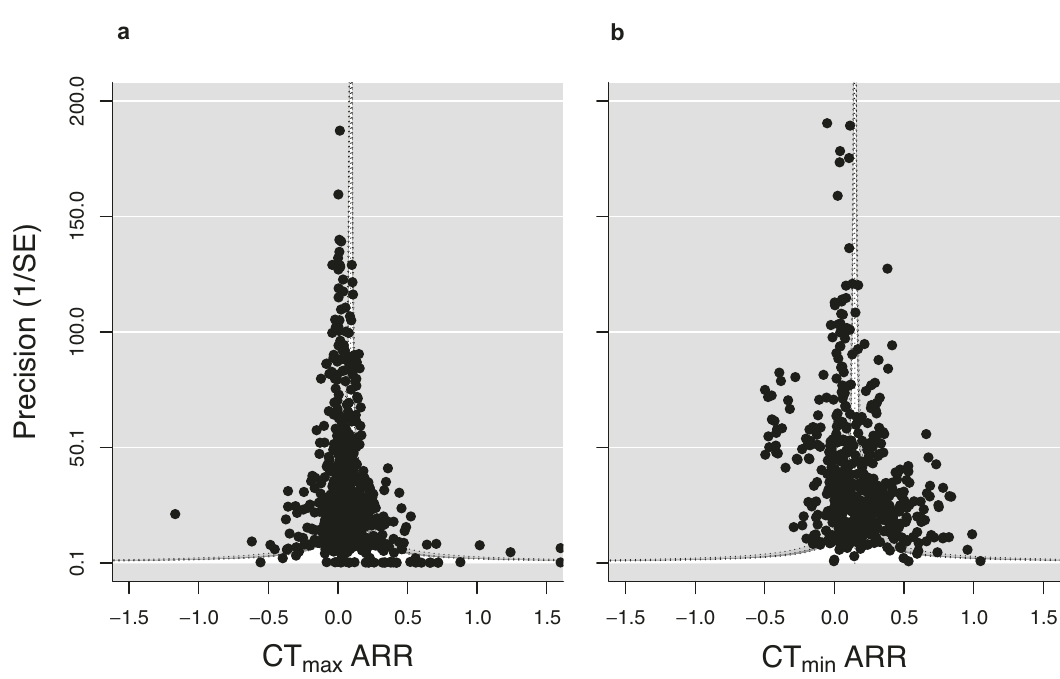
Fig.5|Publicationbiasinacclimationresponseratios(ARR)ofcriticalthermallimits,aCT max (k=803)andbCT min (k=571). Moreprecisestudies(thosewithhigher 1/SE (Standard Error) are located at the top of the plot, and less precise studies are located at the bottom. Egger ’ s regression test (two-sided) showed slight signi fi cant positive publication bias for CT max (CT max β ARR=0.288; 95% CI=0.028, 0.548; p =0.030) and CT min (CT min β ARR=0.621; 95% CI=0.068, 1.174; p =0.028) intercept models, indicating that data points are missing from the left-hand side of both plots. Shadings indicate ( p <0.05, p <0.01, p